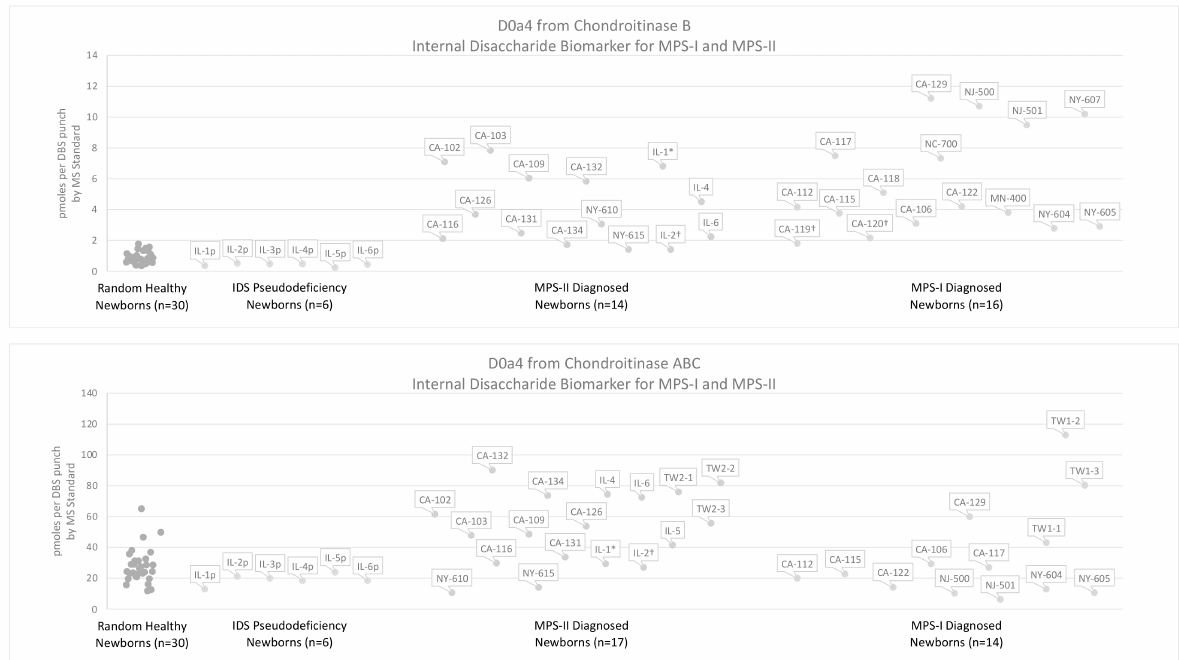
Figure 4. Levels of dermatan-sulfate-derived (D0a4) disaccharide measured in DBS from 30 random healthy newborns, six newborns with IDS pseudodeficiencies, newborns diagnosed with MPS-II, and newborns diagnosed with MPS-I using the internal disaccharide method with chondroitinase B or chondroitinase ABC digestion in buffer. As a result of limited samples, not all MPS-I and MPS-II newborn samples were tested with both enzymes. Results from 13 severe MPS-I, 2 attenuated MPS-I, and 30 random newborns incubated with chondroitinase B were previously published [16]. * DBS from patient with undetermined phenotype, † DBS from patient with attenuated phenotype (MPS-I or MPS-II), “p” DBS from newborn that failed tier-1 IDS screening, pseudodeficiencies identified, no MPS-II diagnosis, Label key and DBS storage conditions: CA = California (frozen), IL = Illinois (frozen), MN = Minnesota (frozen), TW = Taiwan (frozen), NJ = New Jersey (frozen), NY = New York